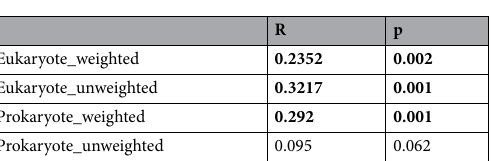
Table 1. Mantel test results for the OTU dissimilarity matrices resulting from the different datasets (Eukaryotic